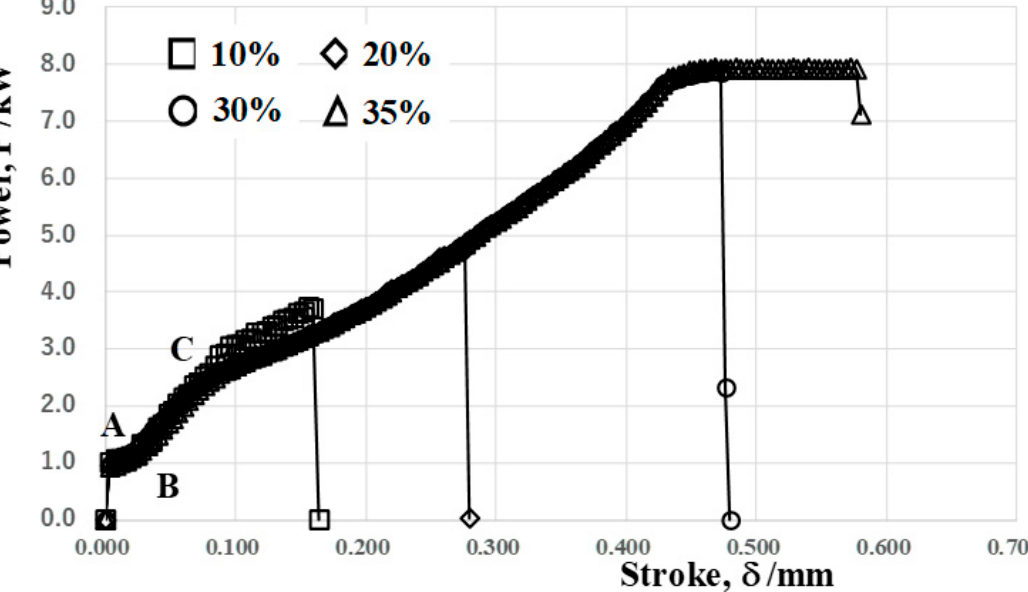
Figure 7. Power to stroke the relationship in the forging of the AISI316 wire with increasing the reduction of the diameter.